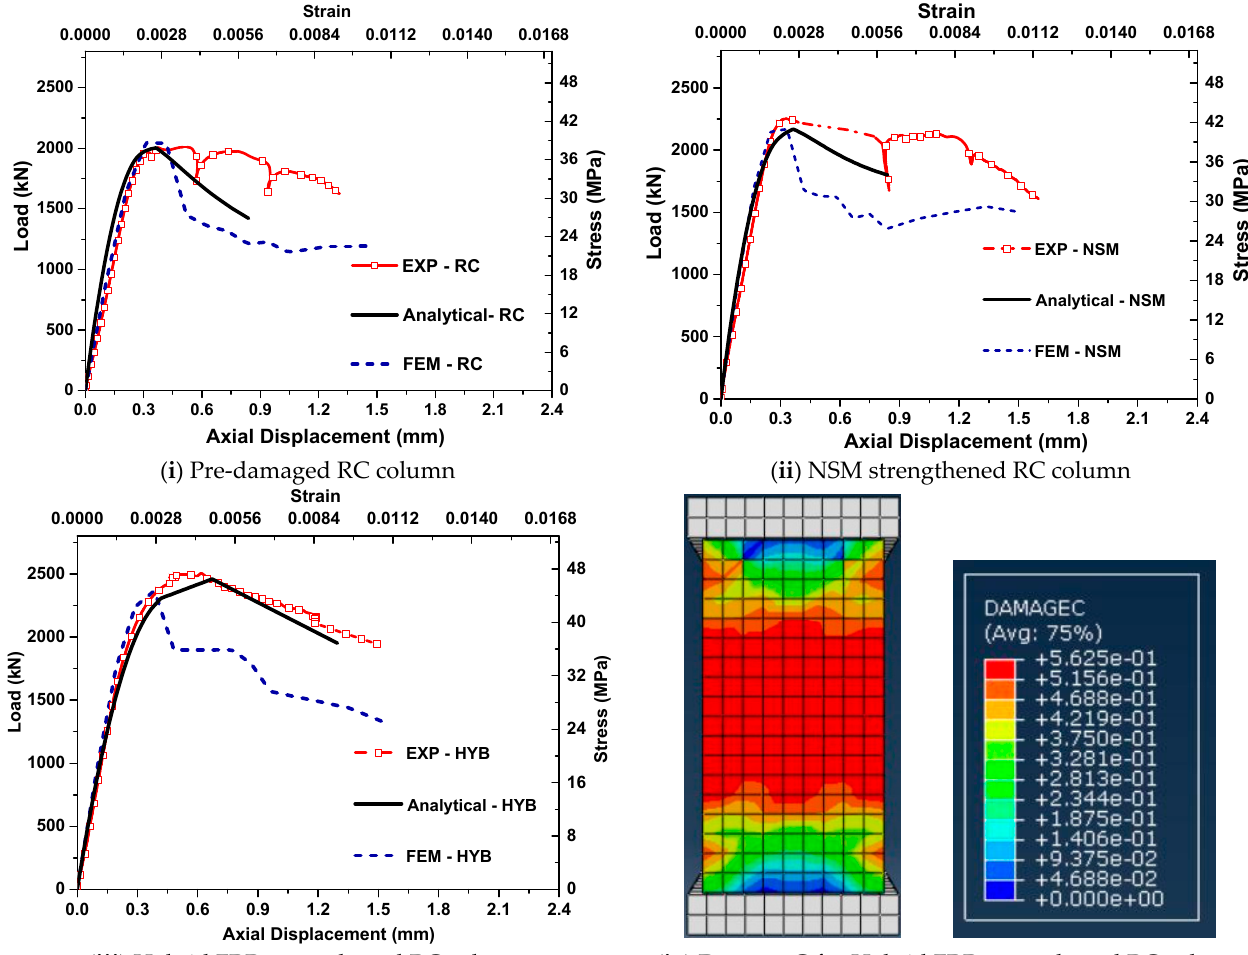
Figure 13. Comparison of pre-damaged RC columns under axial compression.